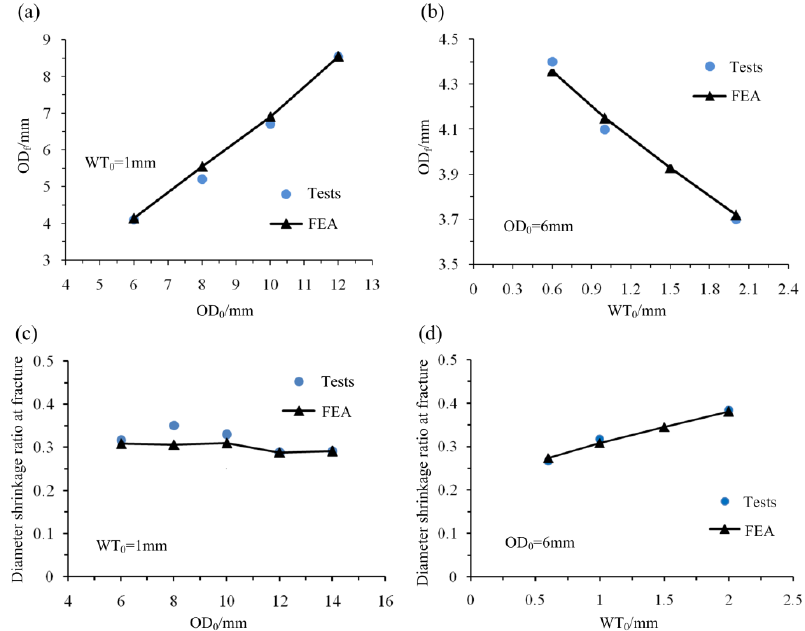
Figure 12. Effect of original diameter and wall thickness on tube diameter at fracture: ( a ) Effect of original diameter on fracture diameter; ( b ) Effect of original wall thickness on fracture diameter; ( c ) Effect of original diameter on diameter shrinkage; ( d ) Effect of original wall thickness on diameter